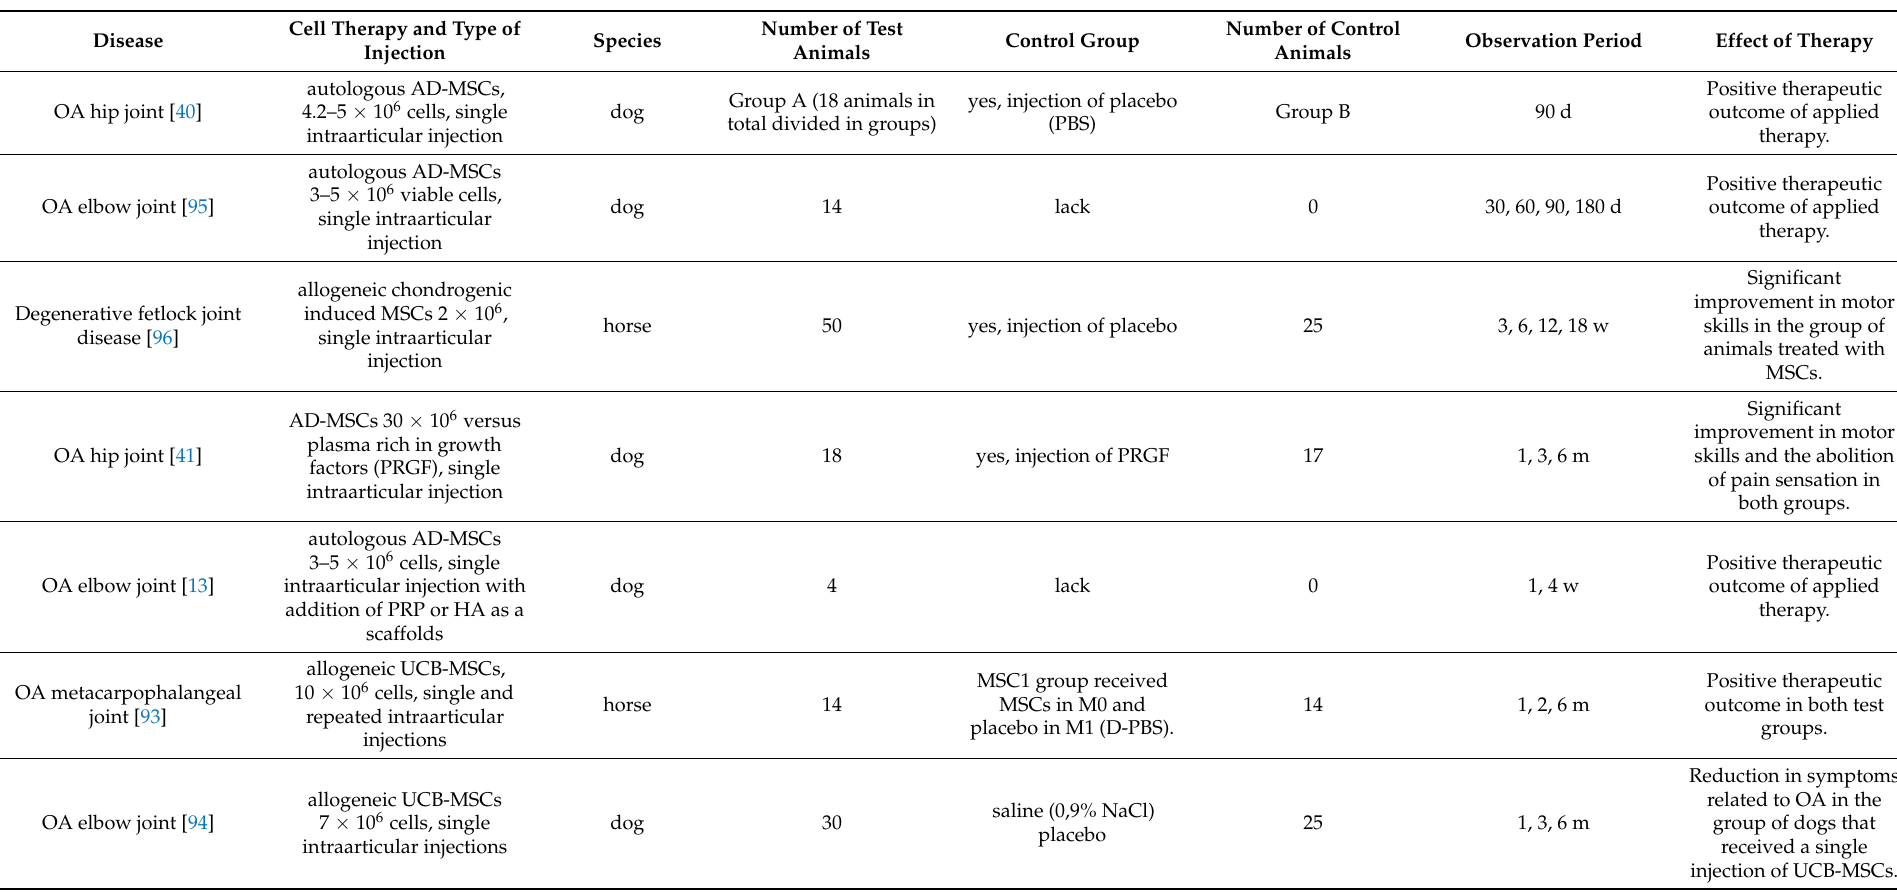
Table 1. A collection of selected papers describing the use of MSCs in the treatment of OA in animals. Abbreviations: OA —osteoarthritis, AD-MSCs—adipose derived mesenchymal stem cells, PBS—phosphate buffered saline, PRGF—plasma rich in growth factors, PRP—platelet rich plasma, HA—hyaluronic acid, UCB-MSCs—umbilical cord blood mesenchymal stem